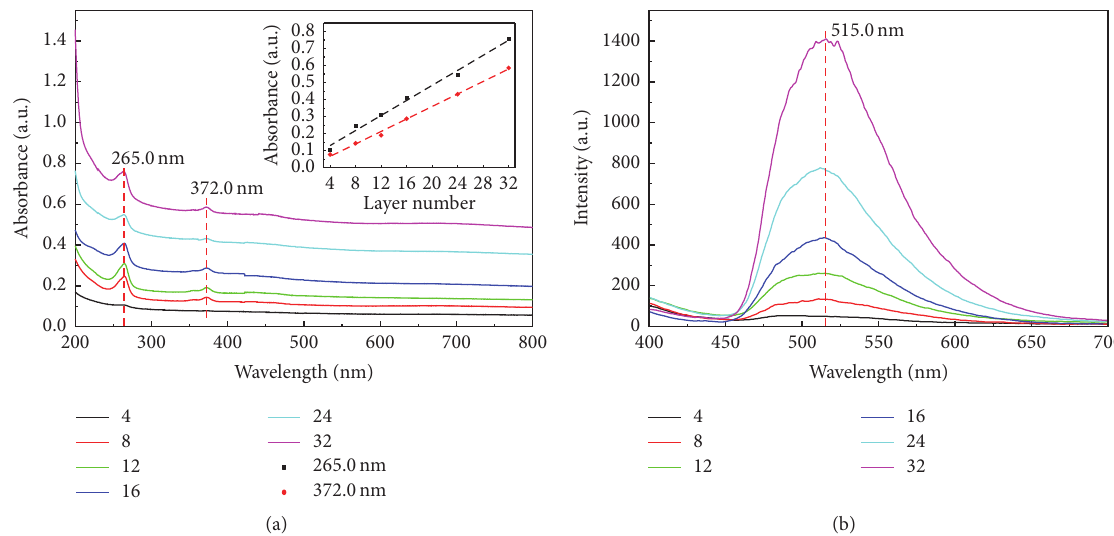
Figure 1: UV-visible absorption spectra and photoluminescence spectra of Mg( 𝑛 )-films. The inset of (a) shows the absorbance increasing linear relationship in 265.0 nm and 372.0 nm.